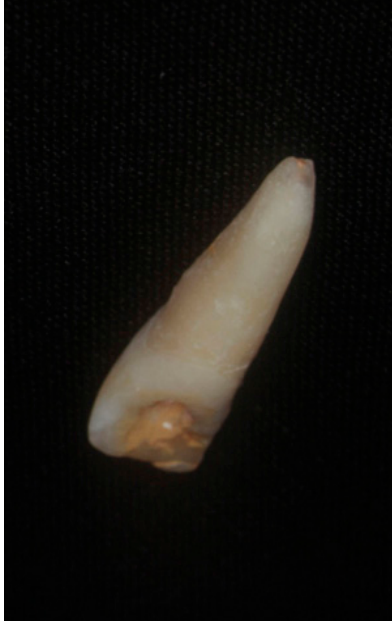
Figure 2. Tooth 11 after root planing, pulpectomy, and filling with gutta-percha and sealer.